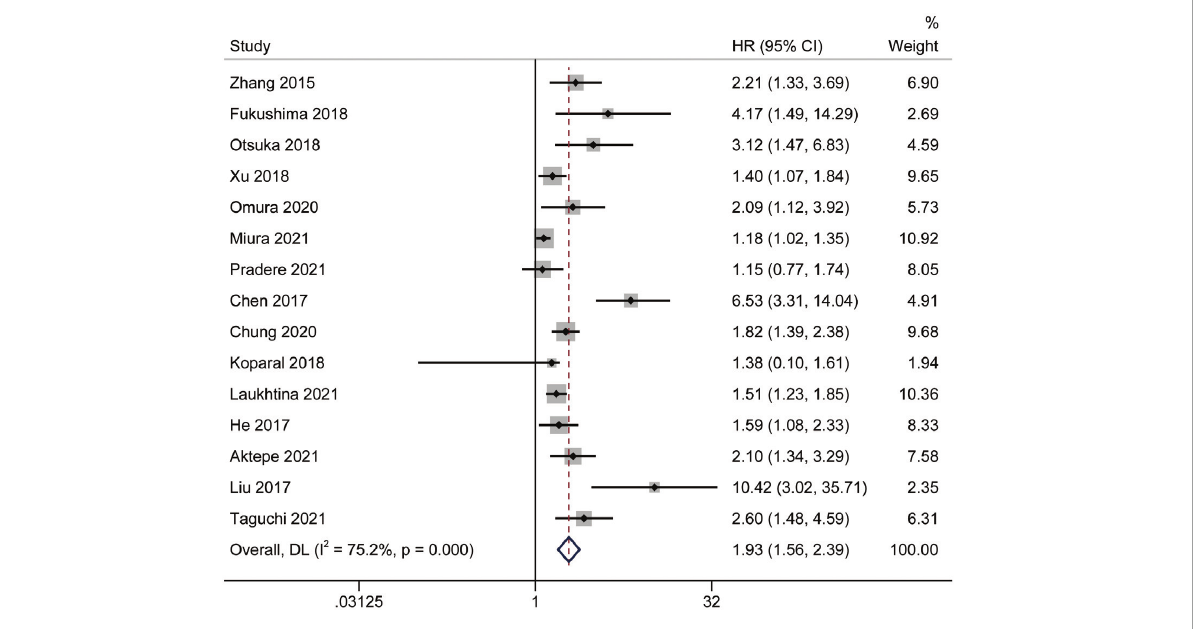
FIGURE2 Forest plot reflects the association between AGR and OS for urological